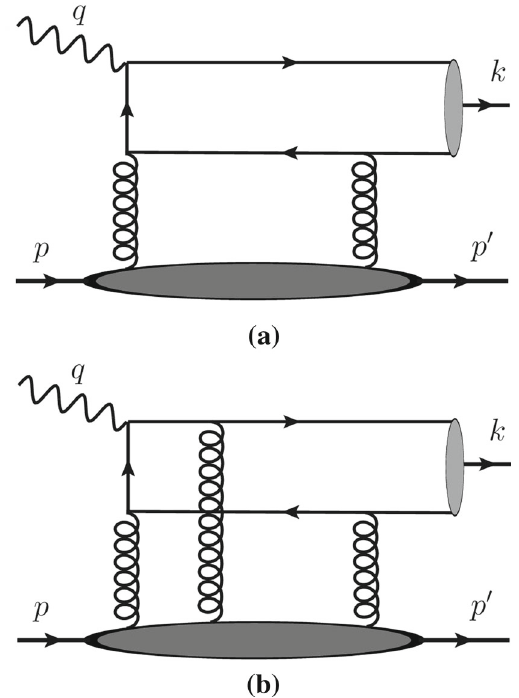
Fig. 1 a One of the six diagrams for two-gluon exchanges. b One dia- grams for three-gluon exchanges. Other diagrams are obtained through